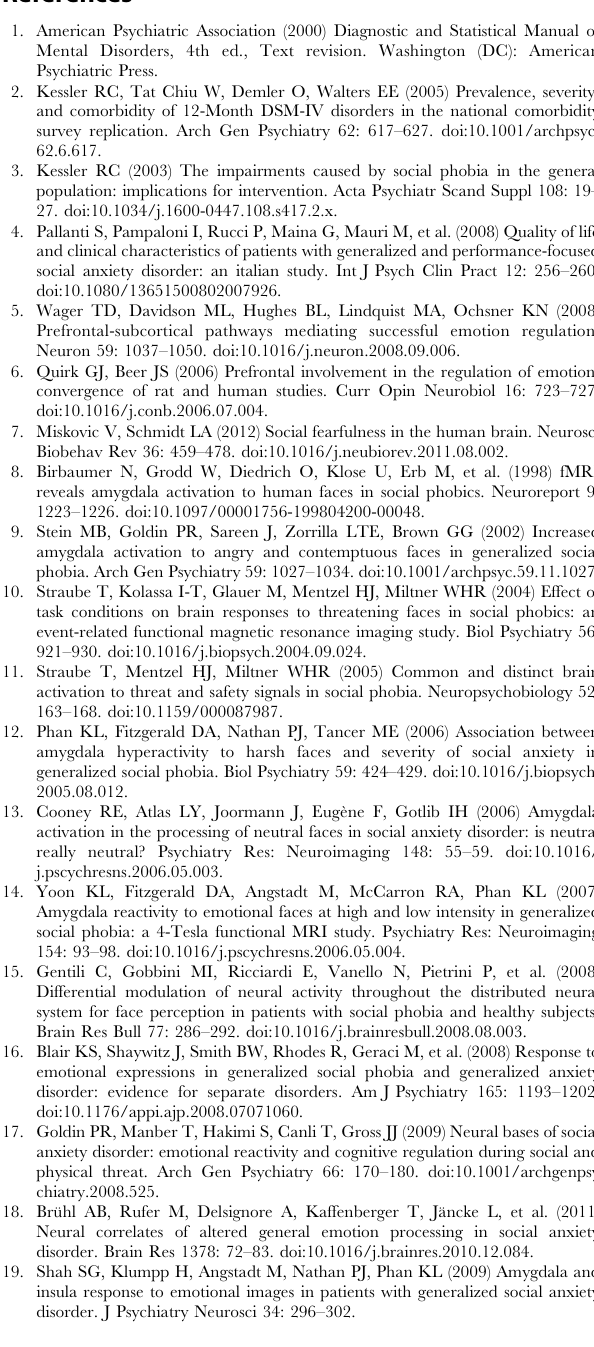
Table S1 Significant whole-brain results for the group x word category ANCOVA comparing activation to negative, SP-related, and positive ( . neutral) words between patients with social phobia (SP) and healthy controls